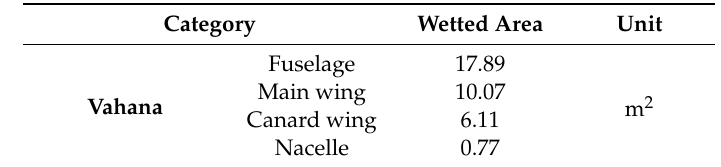
Table 9. Vahana wetted